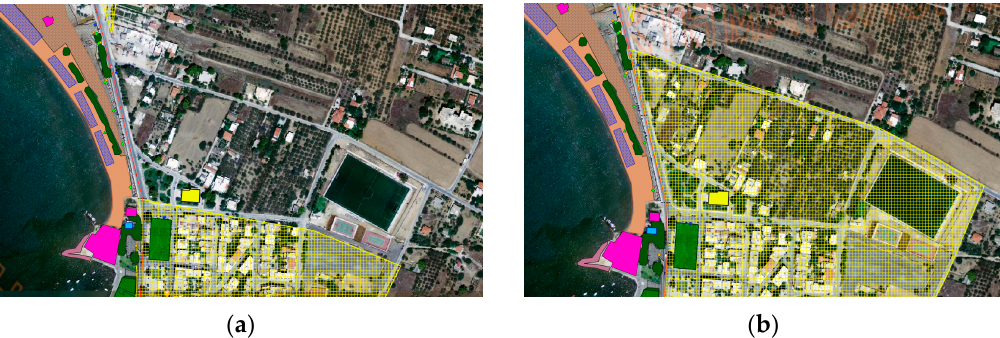
Figure 5. Differences between the initial crowdsourced map ( a ) and the final edited map by the professional ( b ). Source: own elaboration.